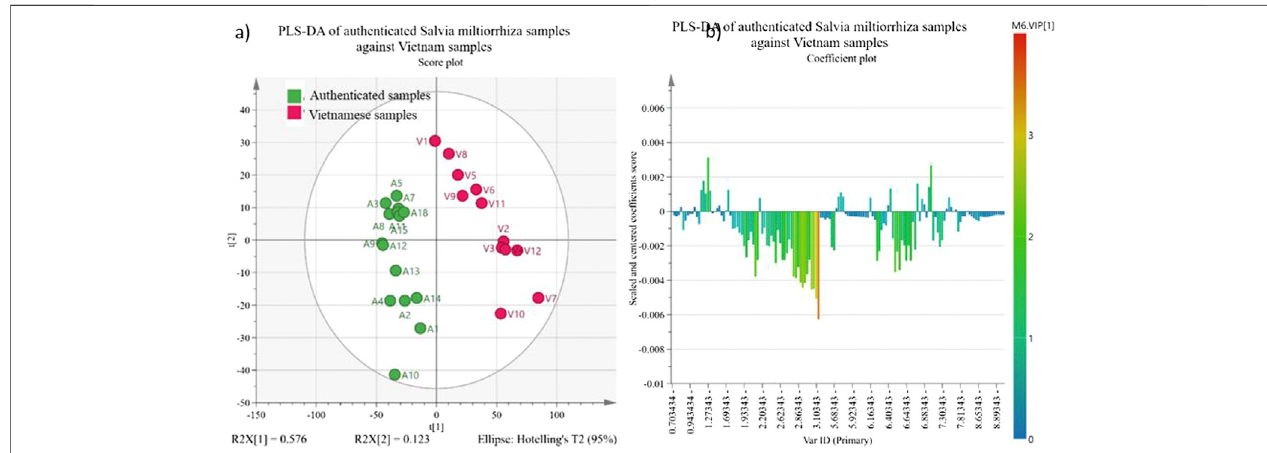
FIGURE 5 | PLS-DA of authenticated S. miltiorrhiza samples against Vietnamese samples. The PLS-DA corresponds to the binned regions of 1 H-NMR spectra of authenticatedSalviamiltiorrhizasamples(A1 – A18,exceptA6,A16,andA17)andVietnamesesamples(V1 – V12)asXvariablesandthesaleschannelofsamplesastheY variable. All X variables are scaled by Pareto scaling. The green colour in (A) PLS-DA scatter score plot and represents the authenticated Salvia miltiorrhiza samples and the pink represents Vietnamese samples. The colours of the samples in fi gure (B) loading plot are referring the VIP value of the X variable contribute to principal component